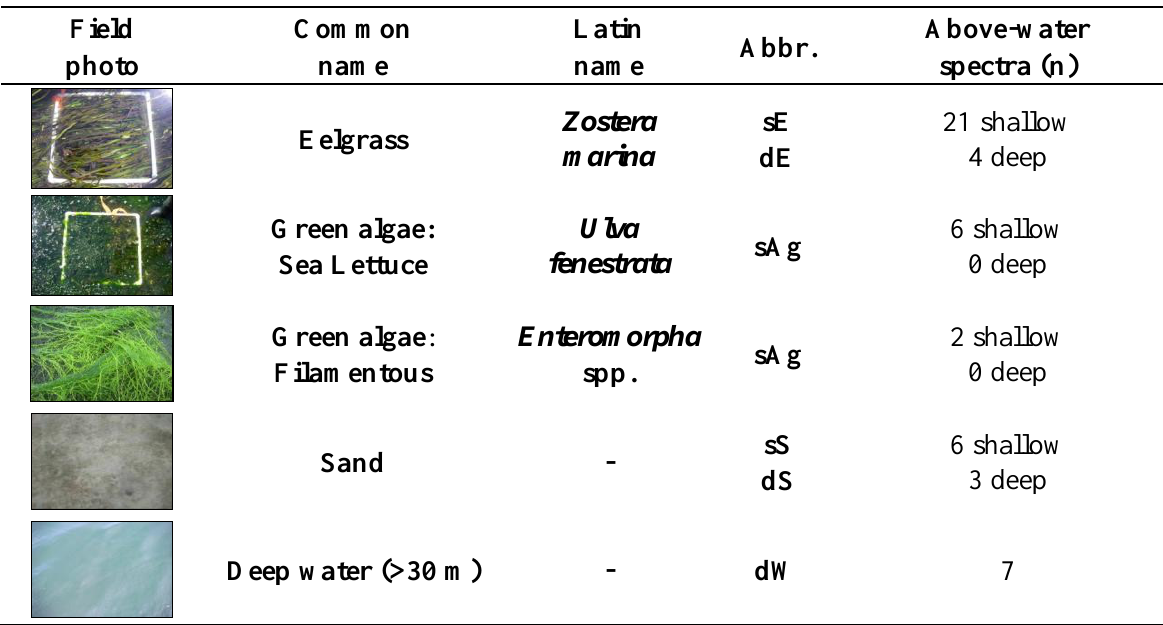
Table 2. Benthic substrates present at the Sidney Spit study site and number of spectral samples acquired for each. E = eelgrass, Ag = green algae, S = sand, dW = water > 30 m deep, d = deep, s =